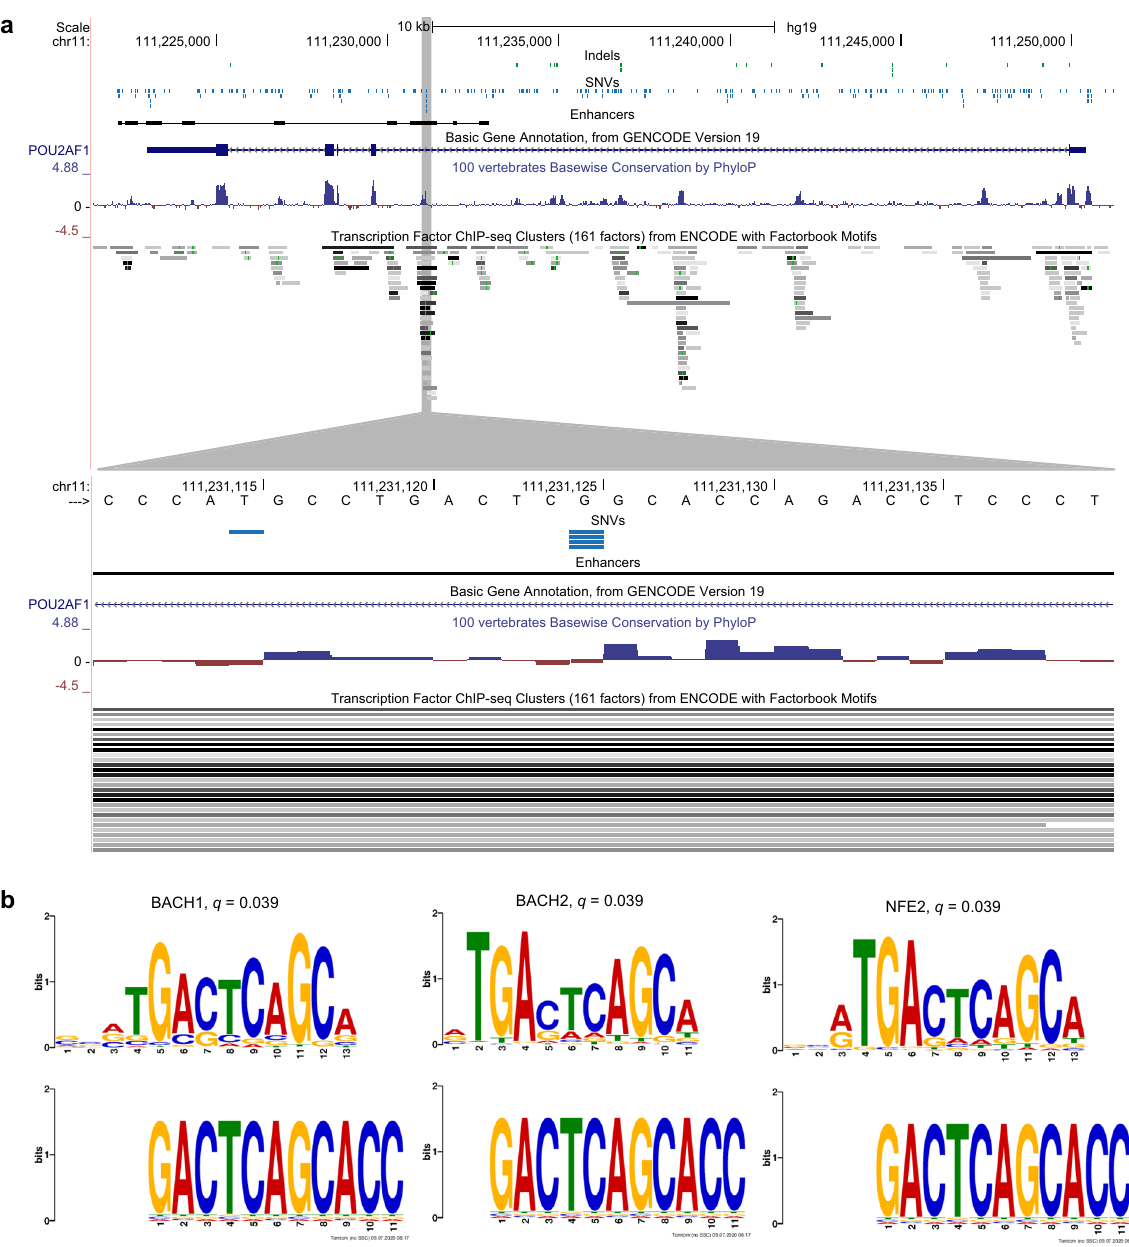
Fig. 6 Genomic region around POU2AF1 . a Genomic features in the area around the POU2AF1 gene including locations of SNVs and indels in the PCAWG dataset, location of enhancers, conservation, and ENCODE transcription factor peaks; the upper panel show the full region; the lower panel show a zoom-in on the hotspot in the POU2AF1 enhancer (made with the UCSC GenomeBrowser). Genomic coordinates are given according to the hg19 reference genome. b Logo-plots for the transcription factor binding motifs for BACH1, BACH2, and NFE2 (made with TomTom 49